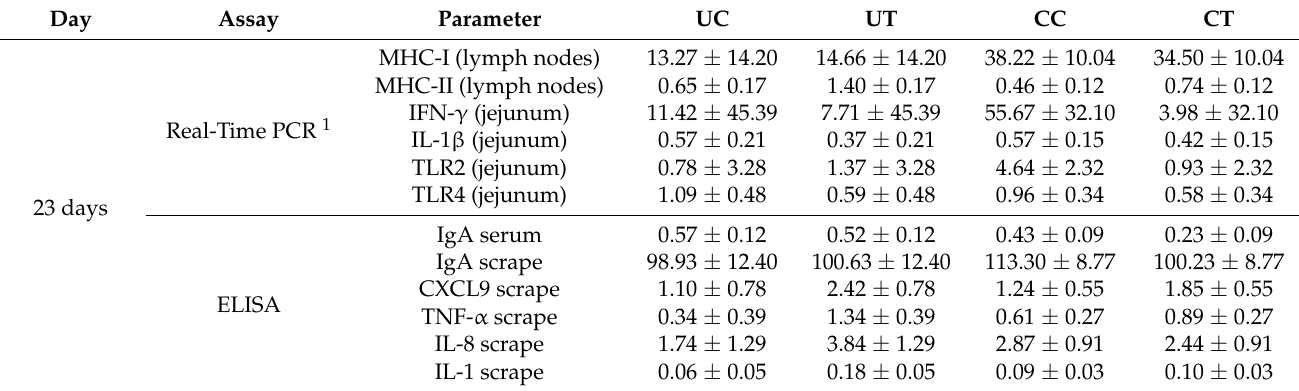
Table 5. Mean values obtained from real-time PCR and ELISA tests among the experimental groups at 23 and 29